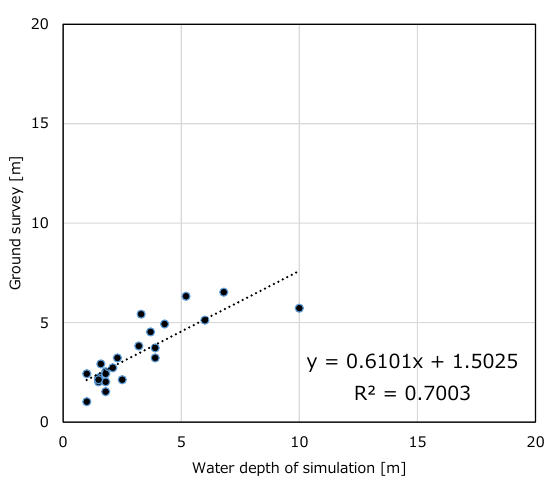
Figure 7. Comparison with ground truth